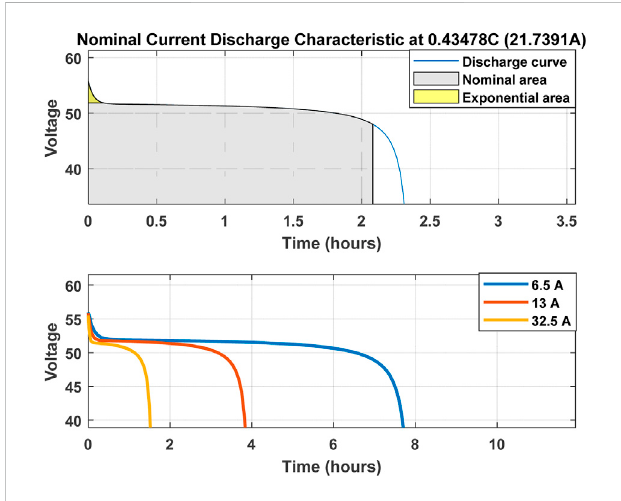
FIGURE 5 The battery characterestics used in this work.